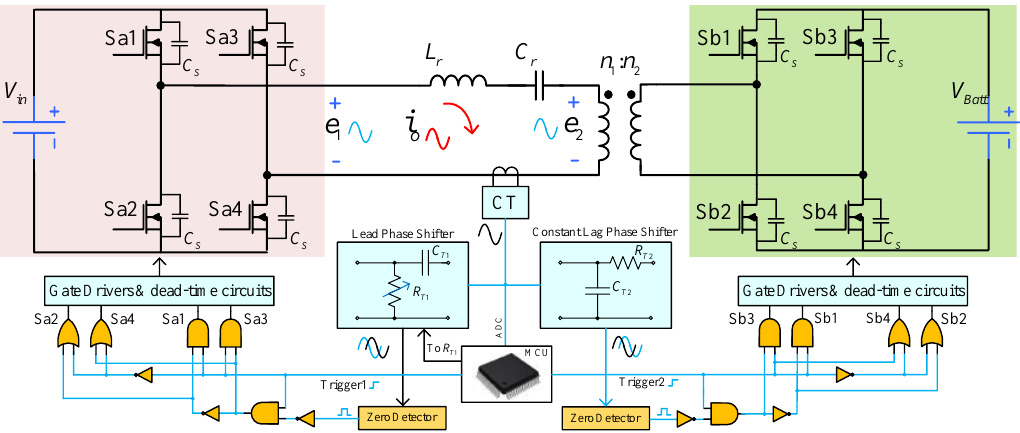
Figure 2. Schematic of the DAB-SRC for a bidirectional battery charging system using the proposed self-tuning method.